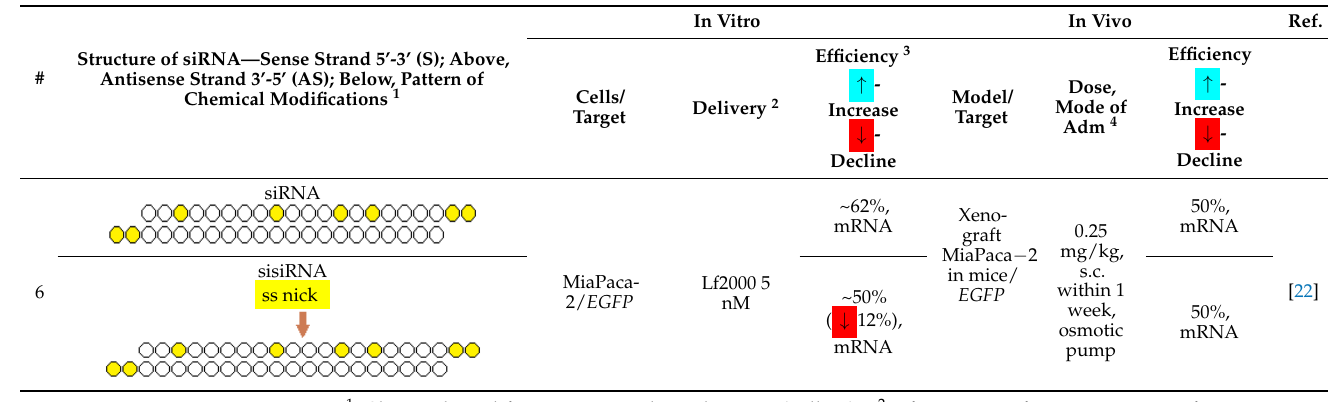
Table 2. Structural modifications of sisiRNA.